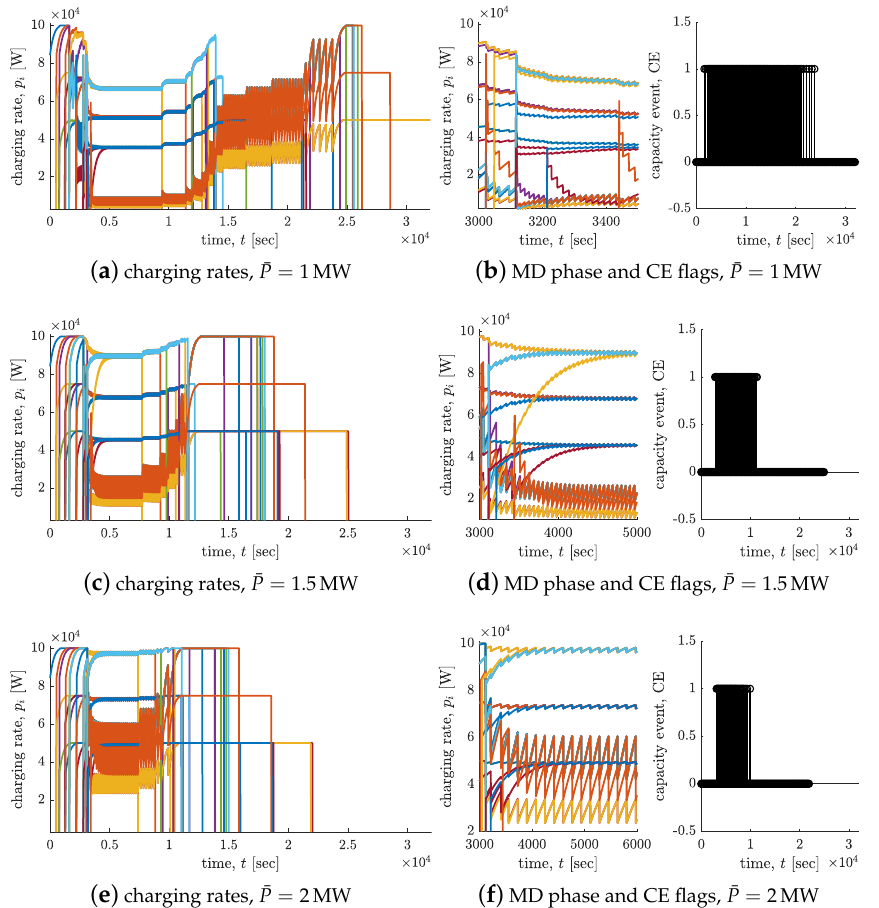
∈ { 50,75, 100 } kW, and the i